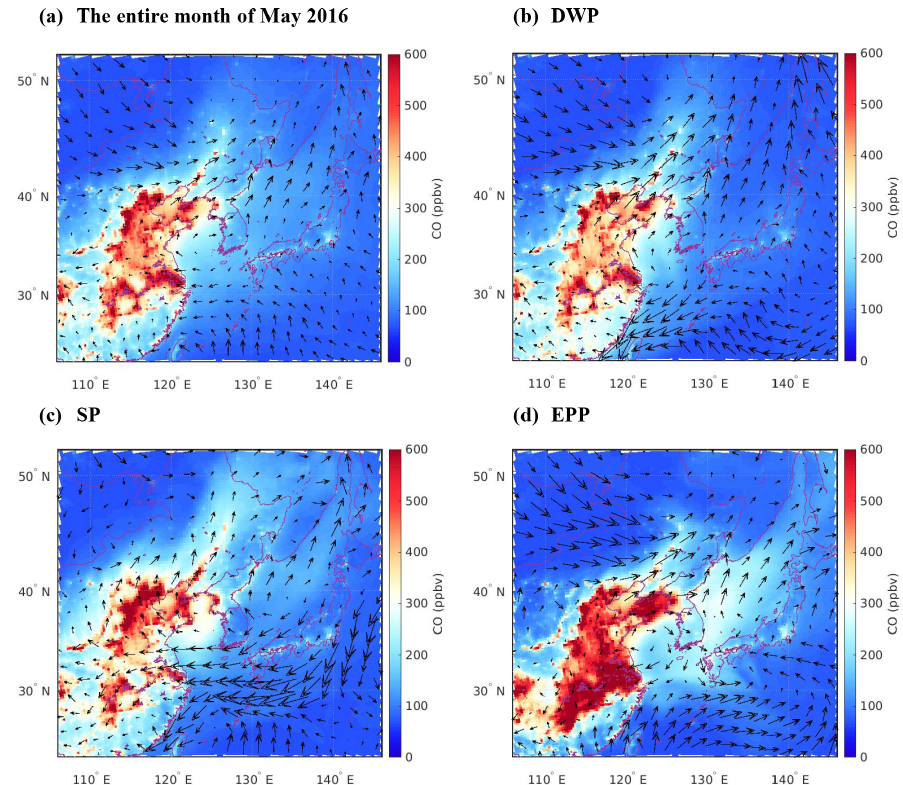
Figure 5. Model CO concentrations and wind patterns over the surface during (a) the entire month of May 2016, (b) the DWP, (c) the SP, and (d) the